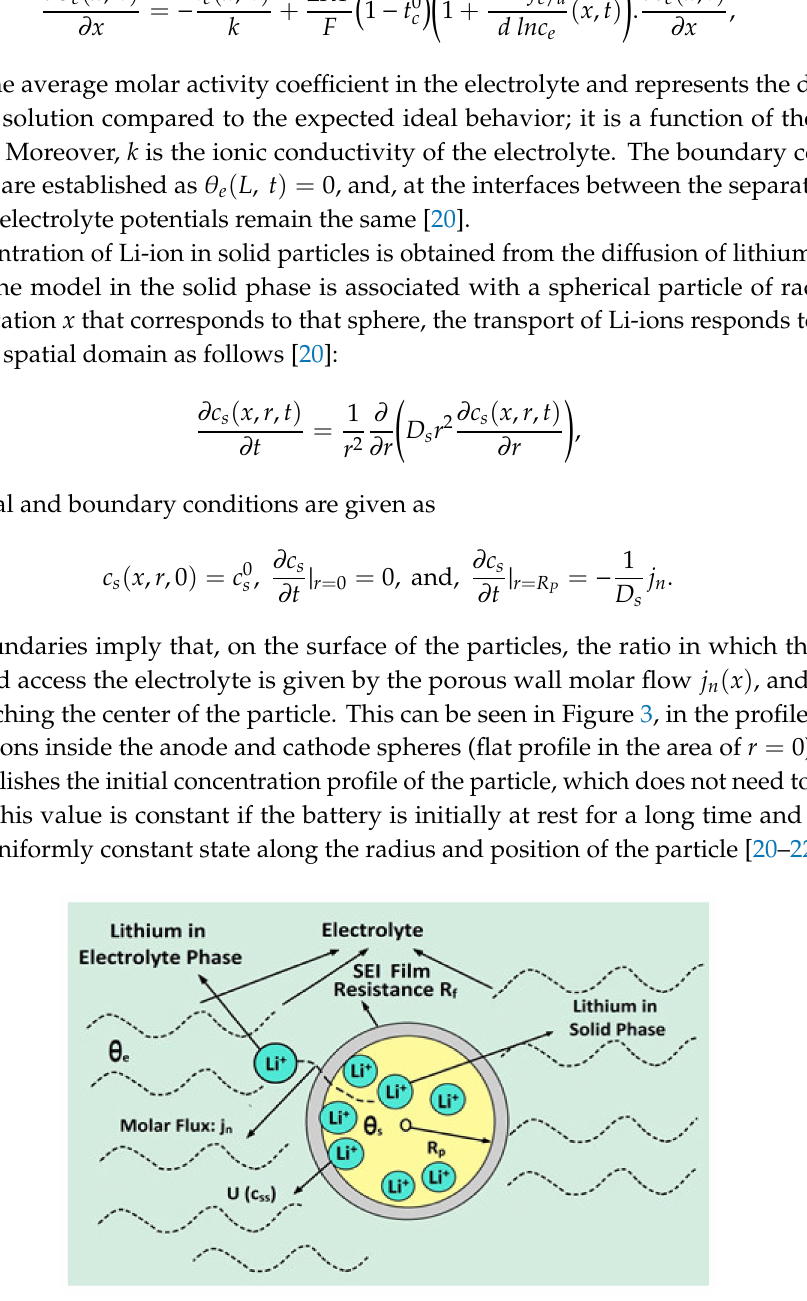
Figure 3. Diagram of molar flux and associated transition of lithium from solid phase to electrolyte phase in the electrode